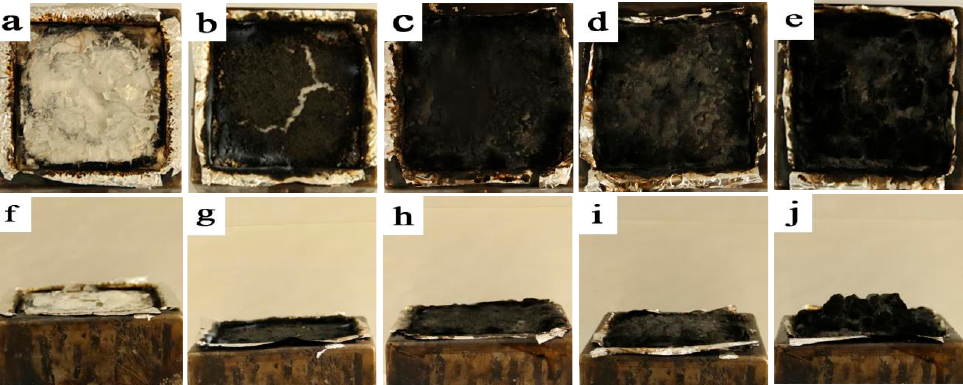
Figure 9. Top and oblique views of cone-tested composites: virgin PLA ( a , f ); mBC/PLA95 ( b , g ); mBC/PLA90 ( c , h ); mBC/PLA85 ( d , i ); and mBC/PLA80 ( e , j ).